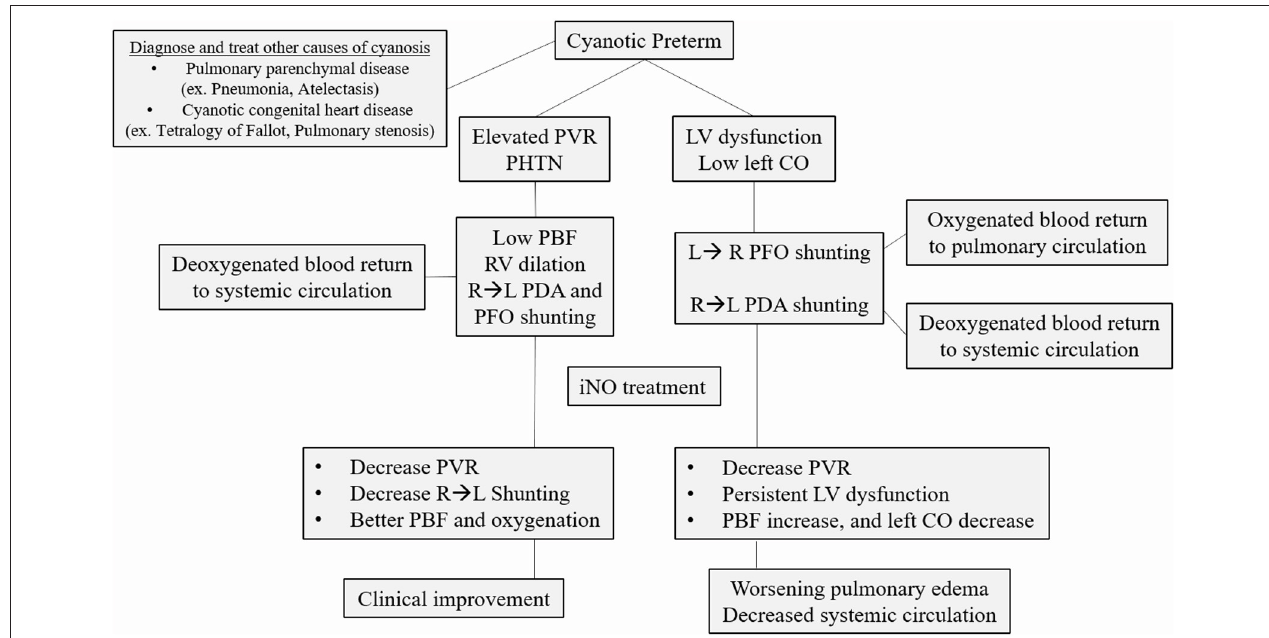
FIGURE 2 | Common causes of cyanosis in the pre-term infant. After ruling out pulmonary parenchymal disease and cyanotic congenital heart disease, the clinician should determine the primary cause of hypoxic respiratory failure. If elevated pulmonary vascular resistance (PVR) with a right to left shunt (RL) is the primary determinant of cyanosis, inhaled nitric oxide (iNO) is the recommended treatment. If there is significant left ventricle (LV) dysfunction, not related to RV dilation from PHTN, iNO can decrease left cardiac output (CO) even further, worsening the clinical status. PBF, Pulmonary blood flow; PHTN, pulmonary hypertension; PFO, patent foramen ovale; PDA, patent ductus